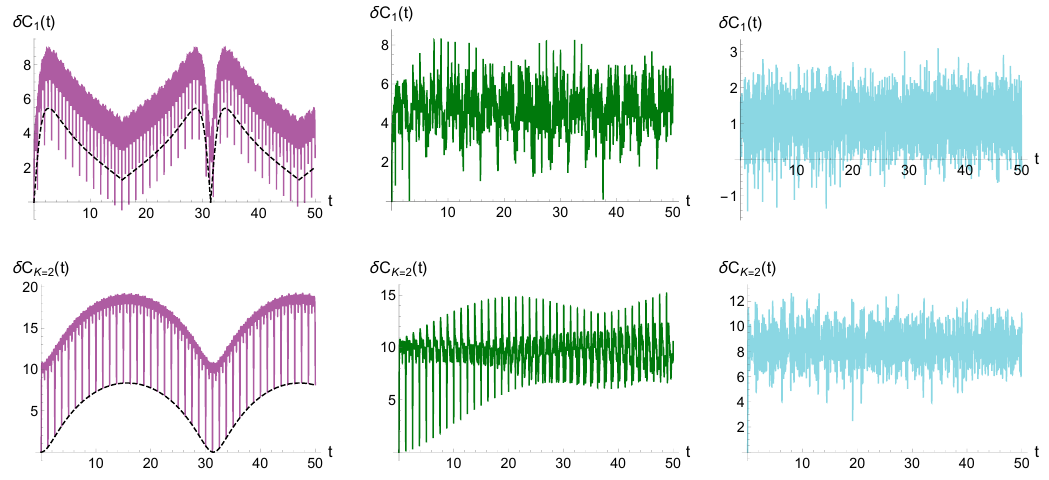
Figure 25 . Evolution of δ C ( t ) as the mass parameter is increased. From left to right m = 0 . 1 , 1 , 10 both in the upper and lower panels. Here L = 1 , N = 1200 , Ω = 0 . 6 and T = 10 , as in the central panels of figure 23 (where m = 10 − 6 ). At lower values of the mass, the zero-mode contribution (dashed black line) is still dominant and sets an overall oscillating behavior on top of which one can observer a pattern similar to the one in figure 23. As the mass increases this regular oscillatory pattern is